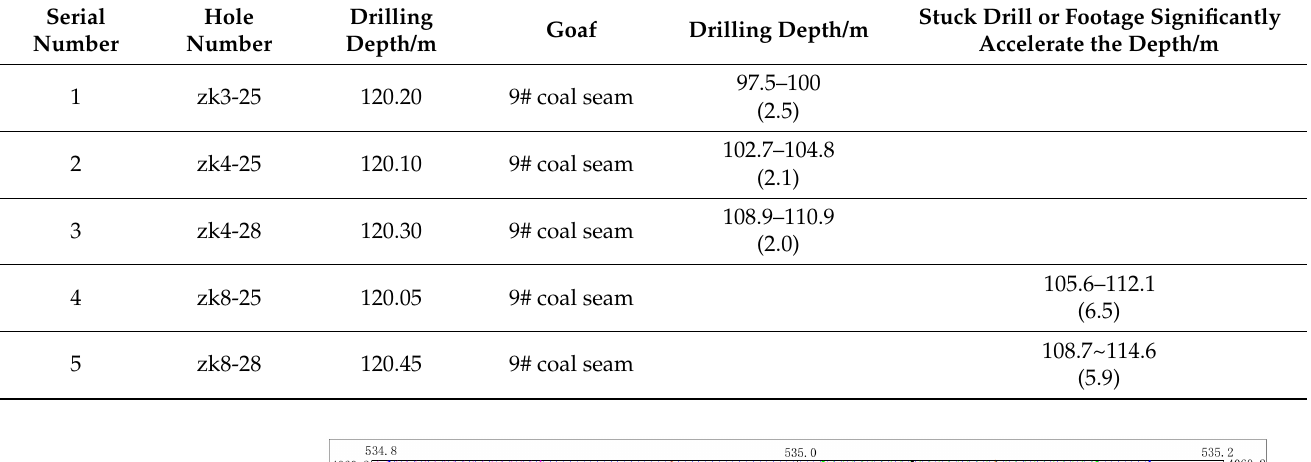
Table 5. List of drilling parameters n the goaf of the 9# coal seam.